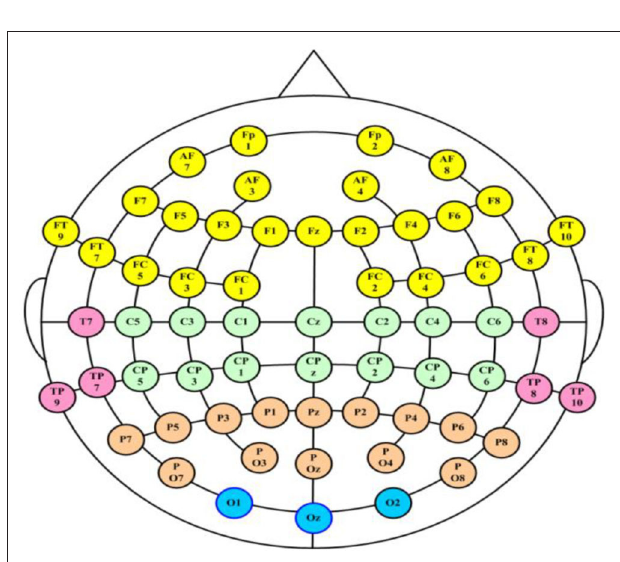
FIGURE 2 | The distribution of the electrodes in the acquisition system.